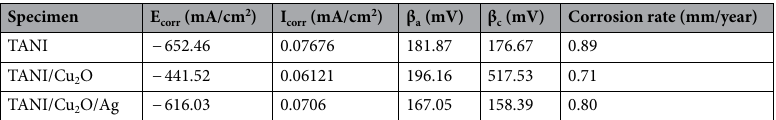
Table 2. Electrochemical parameters estimated from potentiodynamic polarization